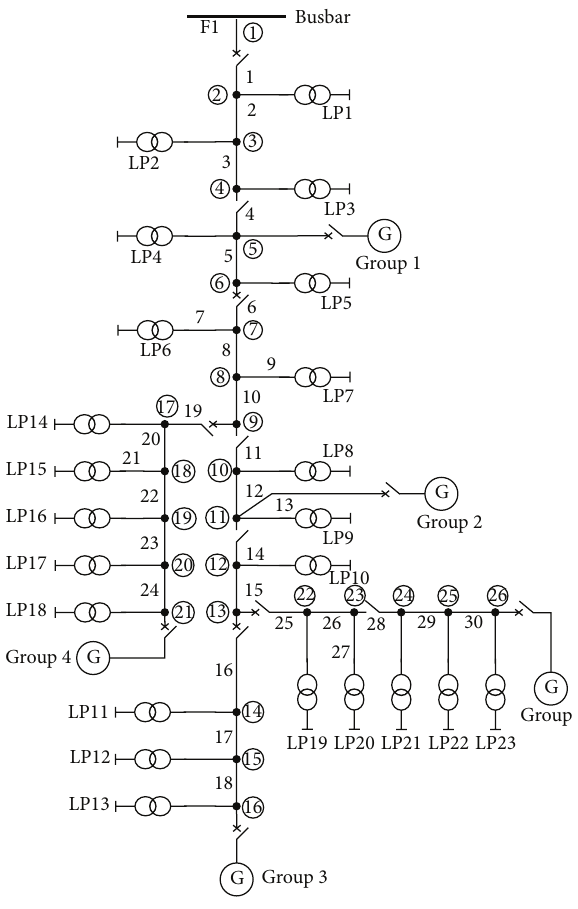
Figure 7: Modified system under study.